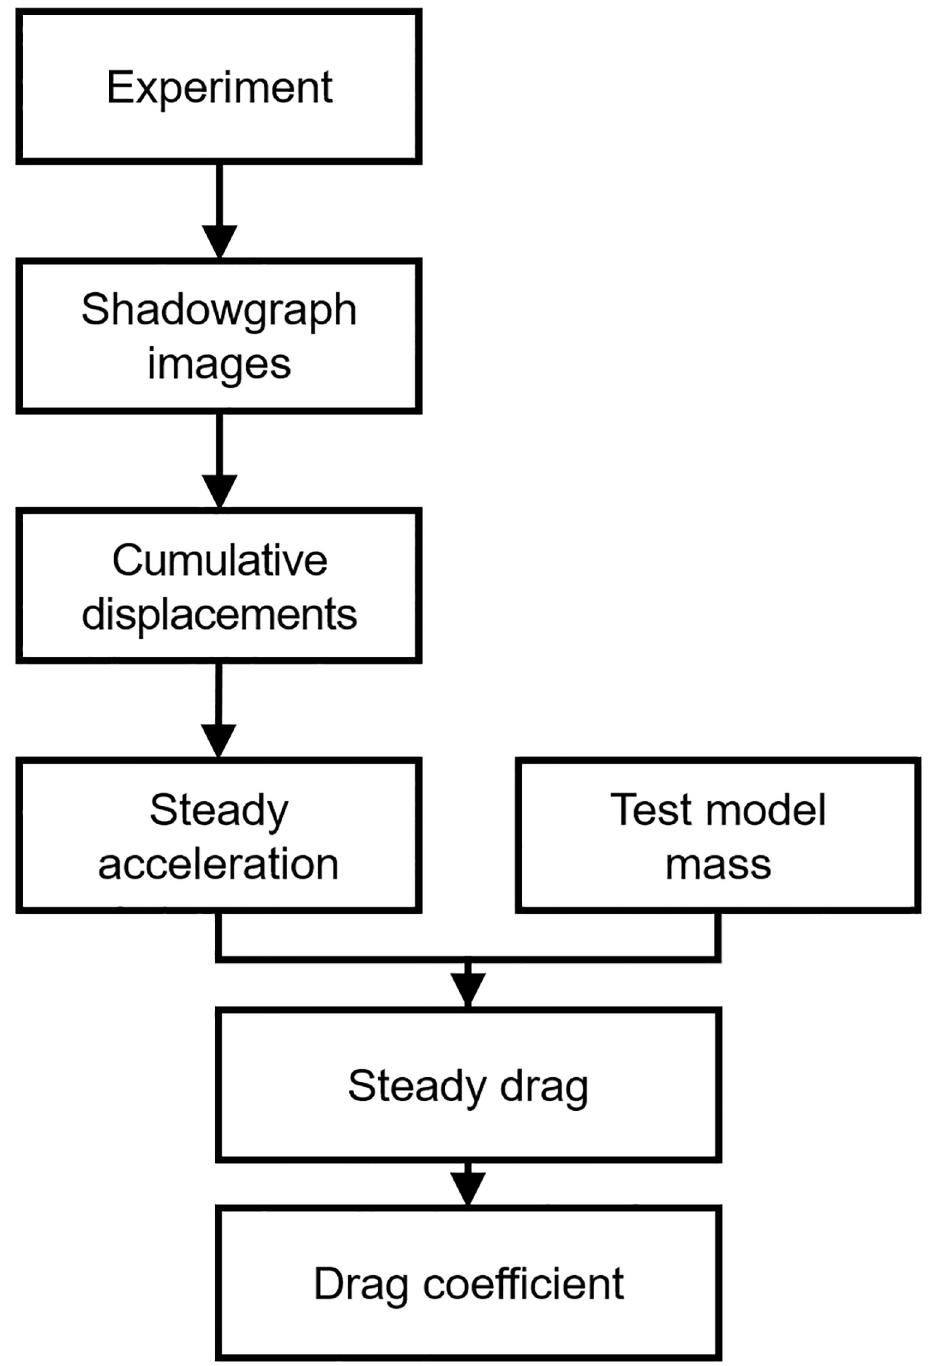
Fig 8. Drag coefficient acquisition using the